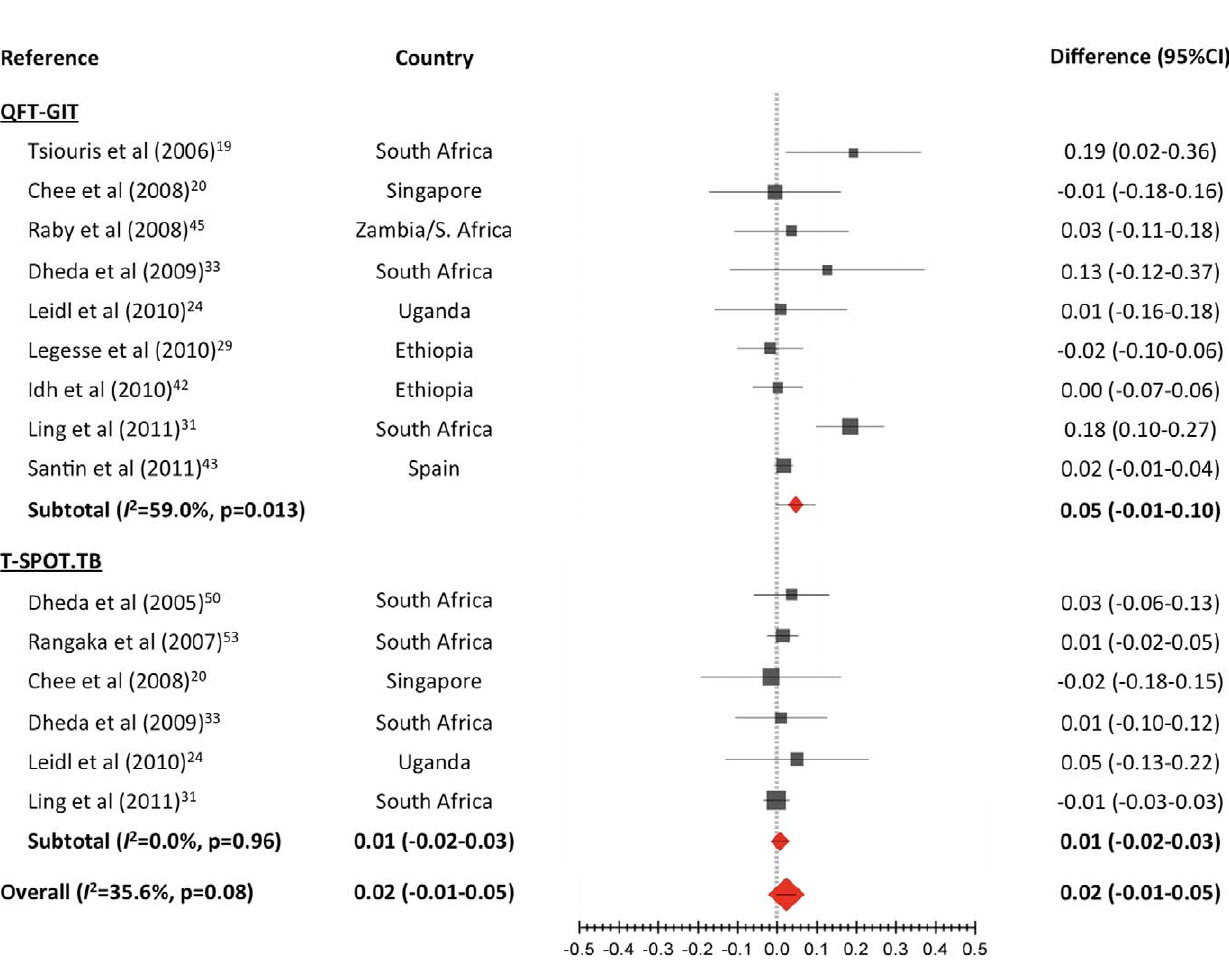
Figure 5. Comparison of the proportion of indeterminate results between HIV-infected and HIV-uninfected individuals. Pooled estimates derived from random effects (DerSimonian-Laird) modeling.